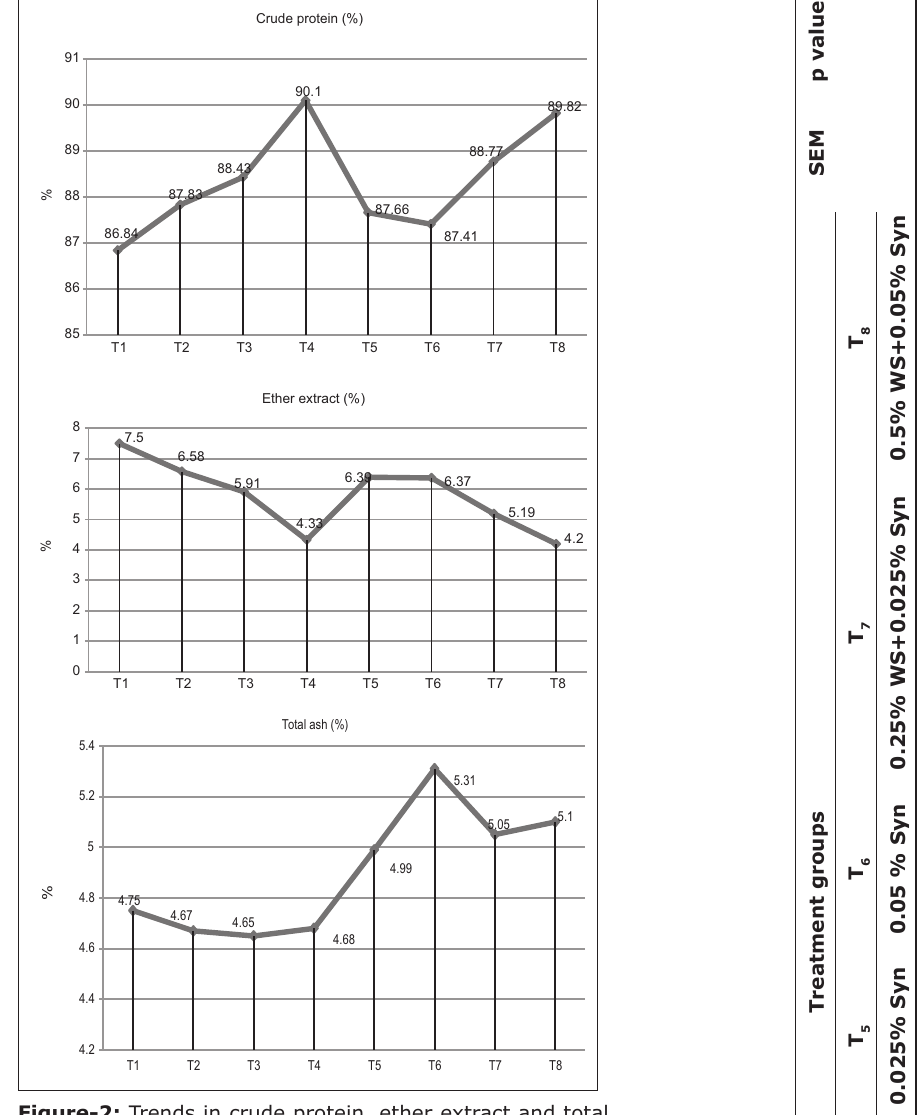
: 1.0% 3 : 0.025% synbiotic, 5